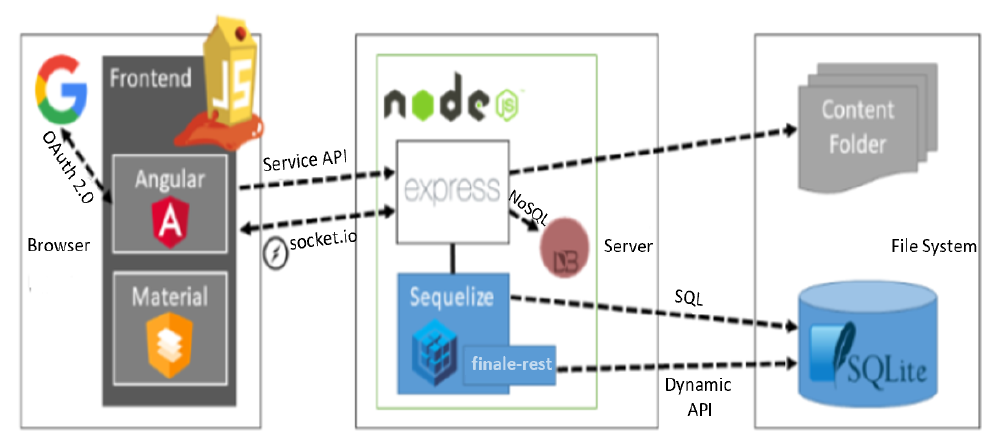
Figure 3. OWASP Juice Shop application architecture